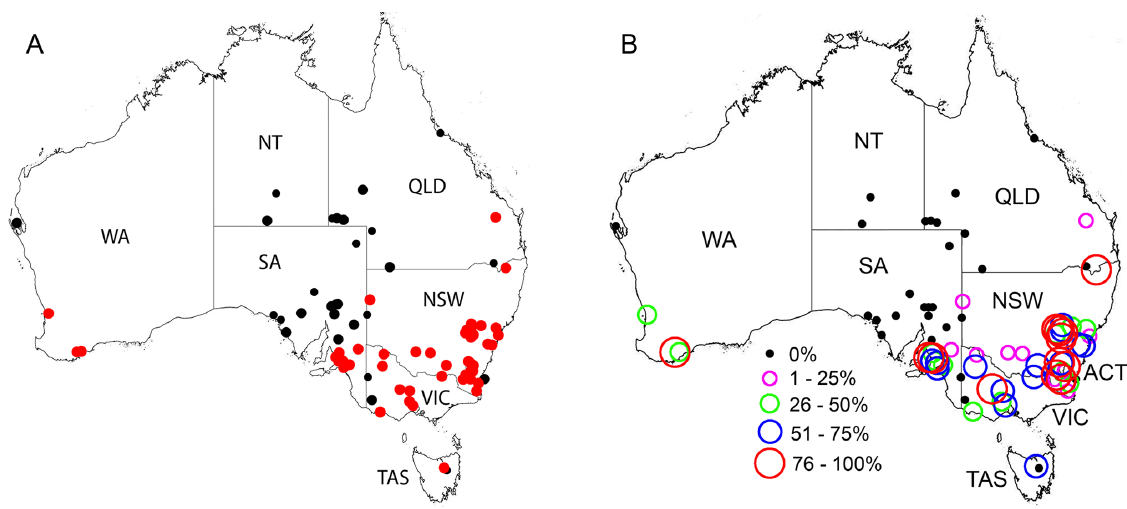
Fig. 1. The distribution and prevalence of RCV-A1 in wild rabbit populations in Australia. (A) The presence (red dot) and absence (black dot) of RCV- A1 at different sites. Black dots at smaller size indicate sites with sample numbers less than 20. (B) Prevalence of RCV-A1 at the 78 sites tested. Black dot: prevalence of RCV-A1 is 0% in the tested samples. Circles with varied size and colour indicate the different prevalence of RCV-A1 at each site. WA: Western Australia, NT: Northern Territory, SA: South Australia, QLD: Queensland, NSW: New South Wales, ACT: Australian Capital Territory, VIC: Victoria, TAS: Tasmania. The maps were generated using the ‘‘Mapping and analysis’’ tool from the ‘Atlas of Living Australia’ (http://www.ala.org.au/), licensed under a Creative Commons Attribution 3.0 Australia